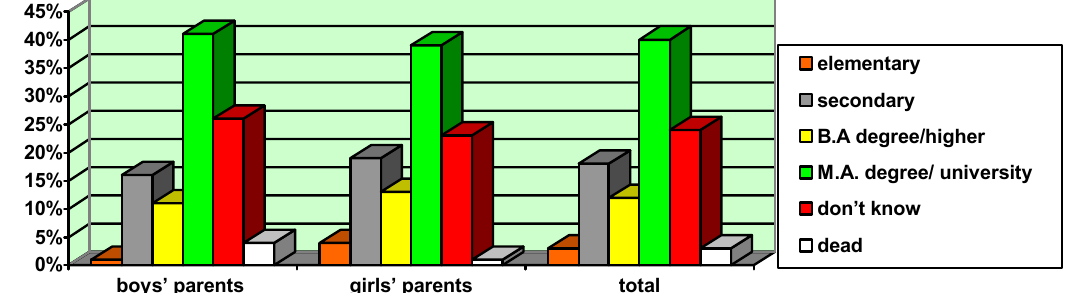
Fig. 1. Education of respondents’ parents,